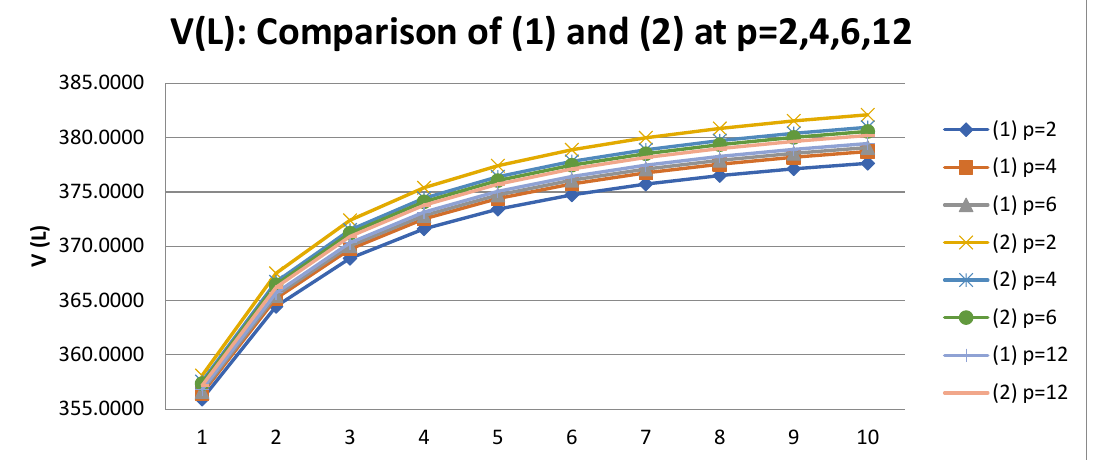
Figure 11. The comparison of the dependence of the company value ( V ) on the leverage level ( L ) of a six-year-old company for profit tax payments that were (1) made at the end of the financial period and (2) made at the beginning of the financial period (i.e., advance payments) with frequencies of p = 2, 4, 6 and 12.